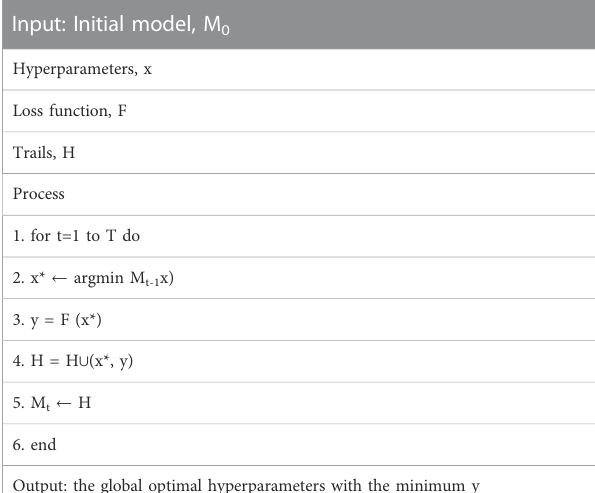
TABLE 1 Algorithm: Sequential model-based optimization (SMBO). Input: Initial model, M